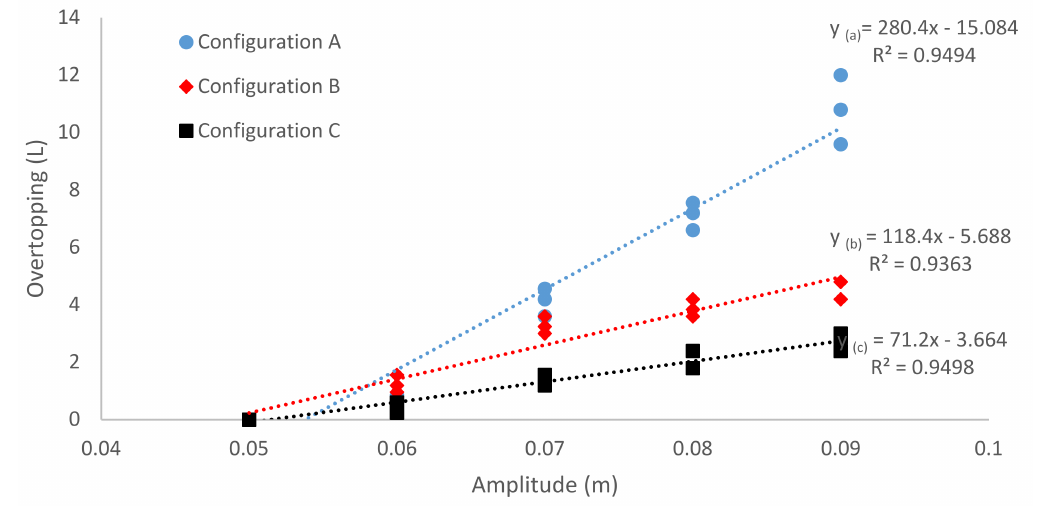
Figure 9. Sine wave hydraulic conditions; overtopping measure vs. amplitude; slope angle adopted within the experimental